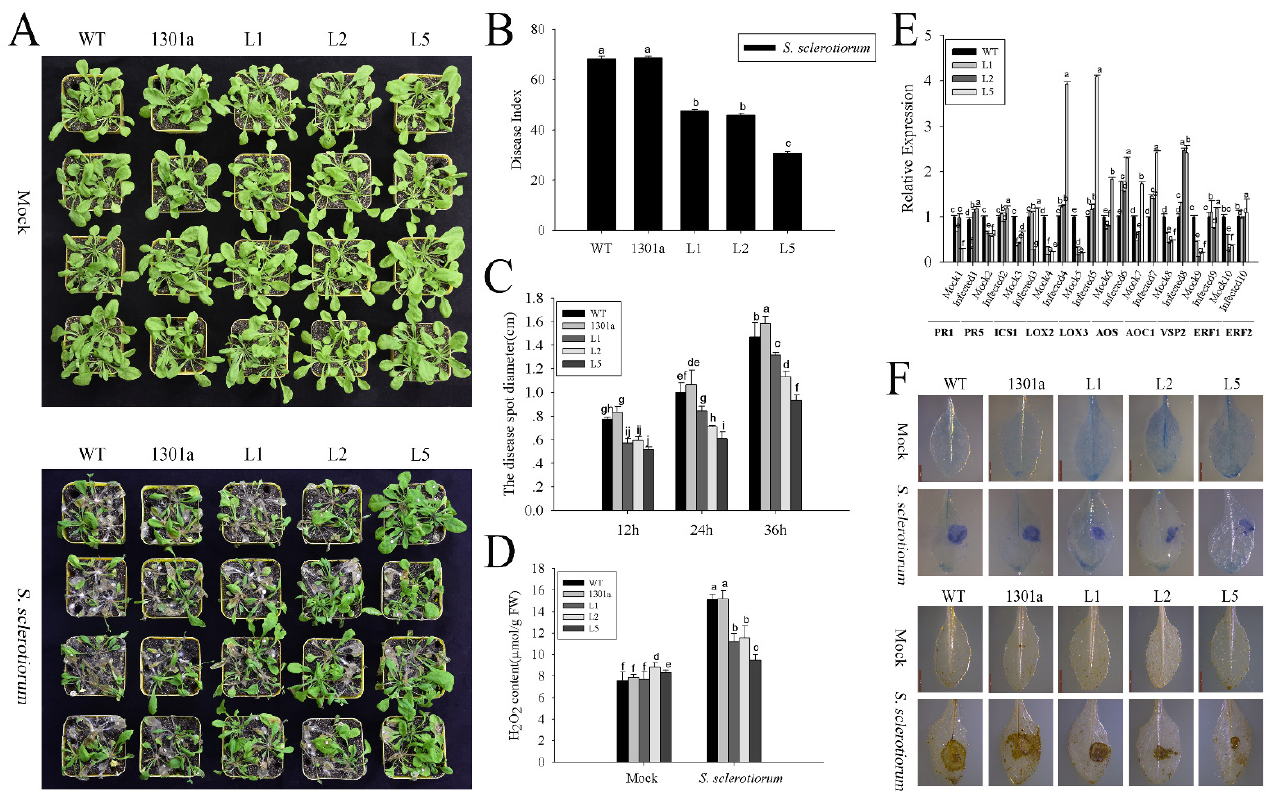
Figure 6. ZmGLP1 increases resistance to Sclerotinia sclerotiorum in Arabidopsis. ( A ) Phenotypes of different groups before and after being treated with Sclerotinia sclerotiorum at 3 d. ( B ) The disease indexes of different groups at 3 d. ( C ) The disease spot diameter of the Arabidopsis leaves in different groups treated with Sclerotinia sclerotiorum at 12, 24, and 36 h. ( D ) H 2 O 2 content in Arabidopsis leaves of different groups at 3 d. ( E ) The expression levels of target plant genes of the salicylic acid, jasmonic acid, or ethephon pathway at 6 h. AtActin2 and AtTUB4 were used as reference genes for normalization. ( F ) Trypan blue staining and DAB staining of different groups of leaves at 3 d. Different letters in subfigures ( B – E ) indicated significant difference between different samples by Duncan’s post-hoc test. Data are presented as the mean ± SD based on three biological replicates.